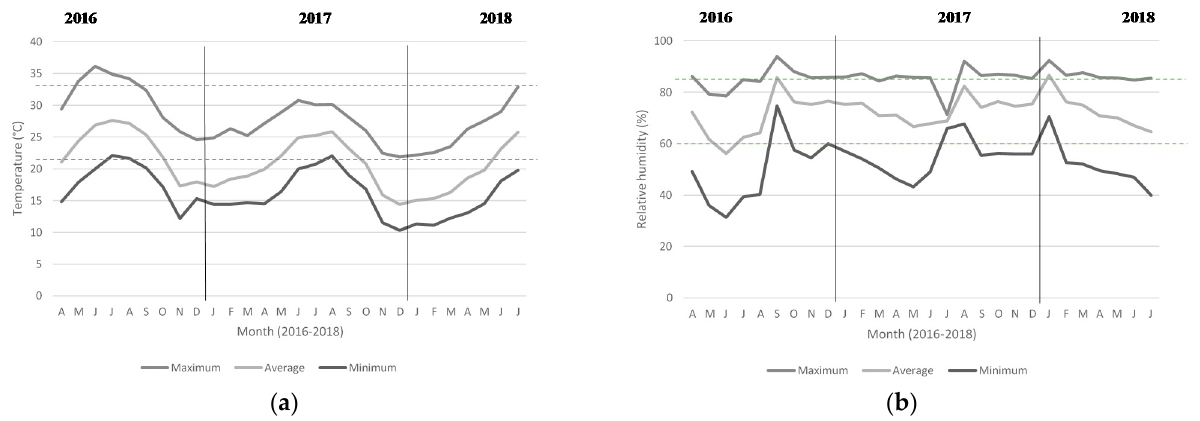
Figure 2. ( a ) Maximum, average, and minimum temperatures and ( b ) relative humidity calculated in the active climate control module. The horizontal dotted lines mark the optimal temperature and relative humidity ranges for papaya crop, according to Nakasone and Paull (1998) [2] and Campostrini and Glenn (2007) [4].